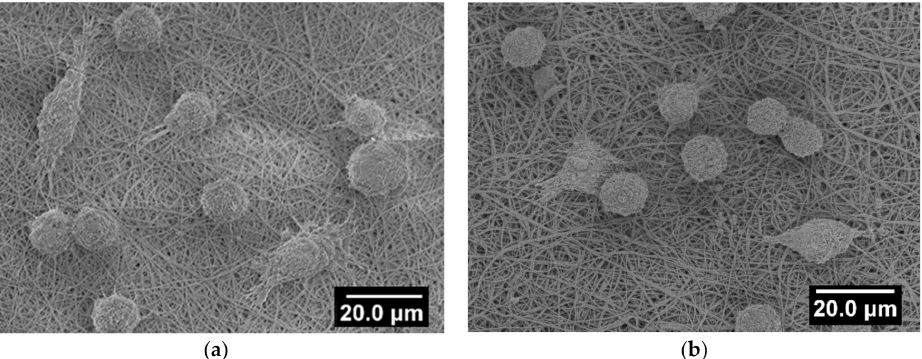
Figure 8. SEM images of L929 mice fibroblast cells on chitosan ( a ) and curdlan–chitosan ( b ) scaffold after 72 h of culture. The images are representative of 3 independent observations (AV 3